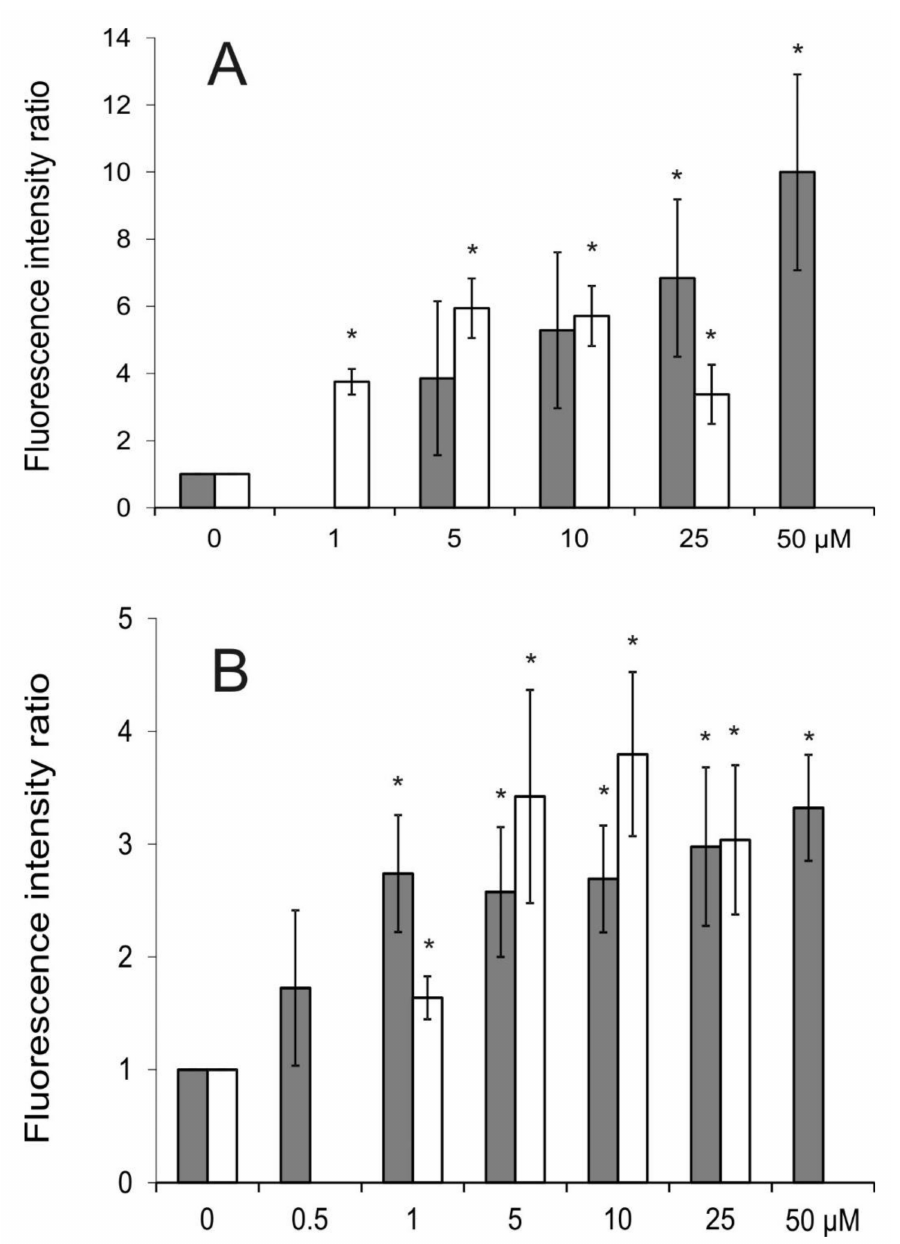
Figure 3. The influence of SILA-409 (gray) and SILA-421 (white) on R123 intracellular accumulation in LoVo / Dx ( A ) and Madin-Darby Canine Kidney-multidrug resistance protein 1 (MDCK-MDR1) cells ( B ). Means ± SD of three experiments are presented. The statistically significant di ff erences from the untreated cells were determined using Student’s t -test (* p <